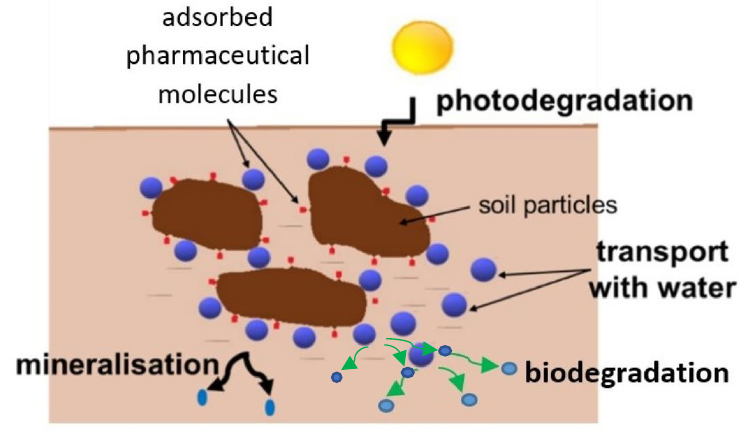
Figure 3. The fate of pharmaceuticals in soil.